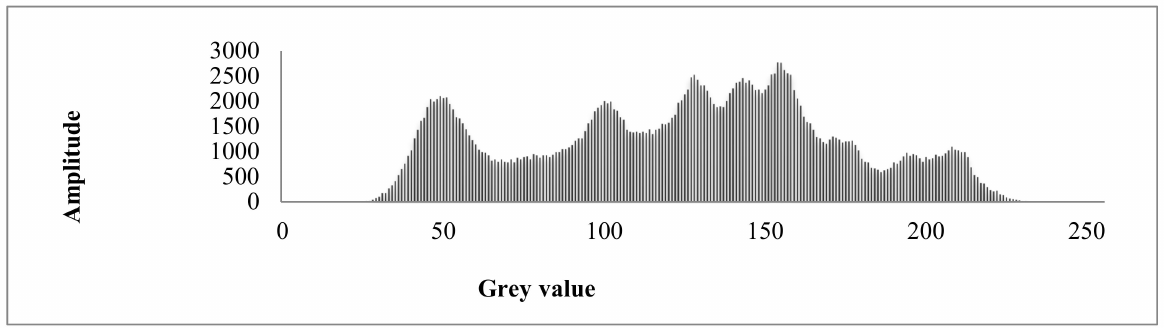
Figure 1. Sample histogram for a pepper